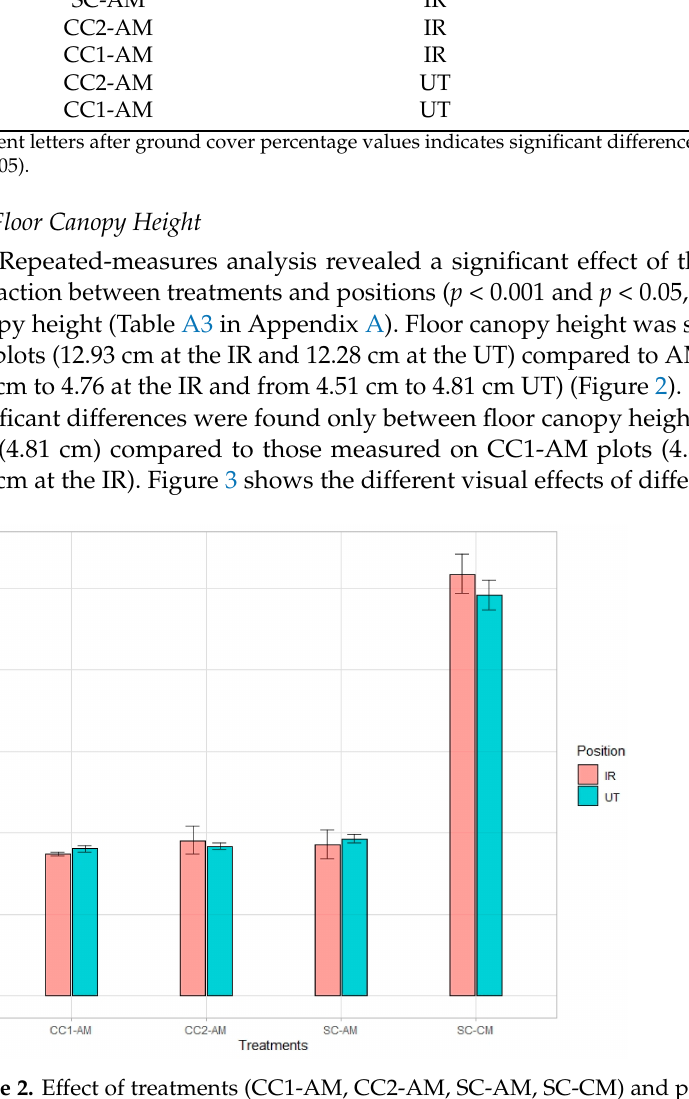
Figure 2. Effect of treatments (CC1-AM, CC2-AM, SC-AM, SC-CM) and positions (IR and UT) on floor canopy height. Error bar represents the upper and lower limits of the 95% confidence